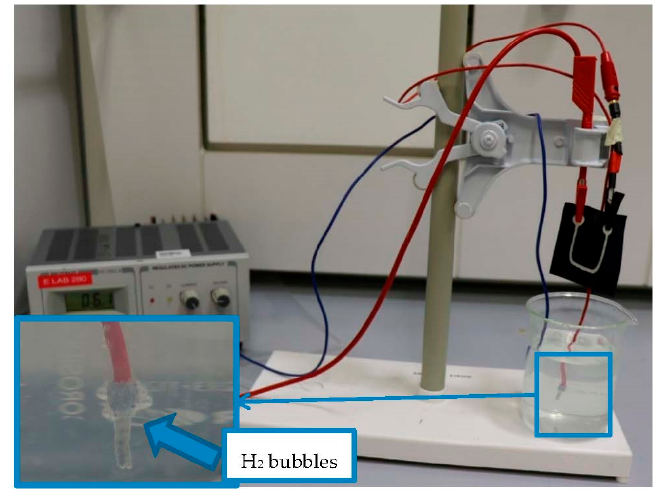
Figure 5. Control of the current flow through the print sample.